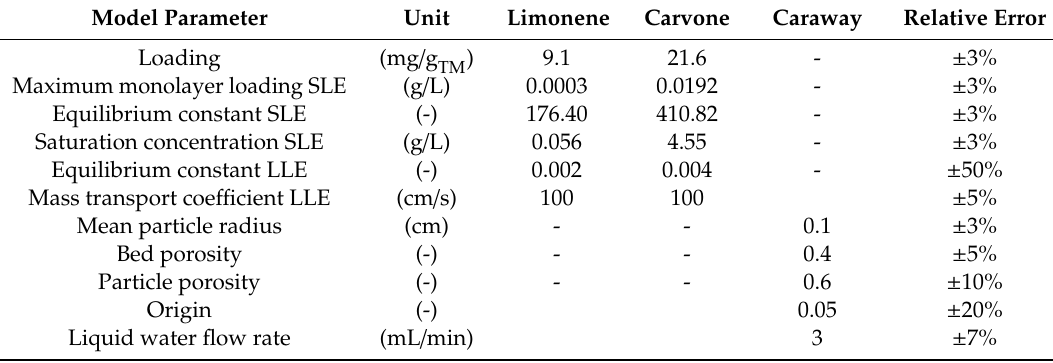
Table 5. Parameters of the accuracy and precision study of the caraway model.